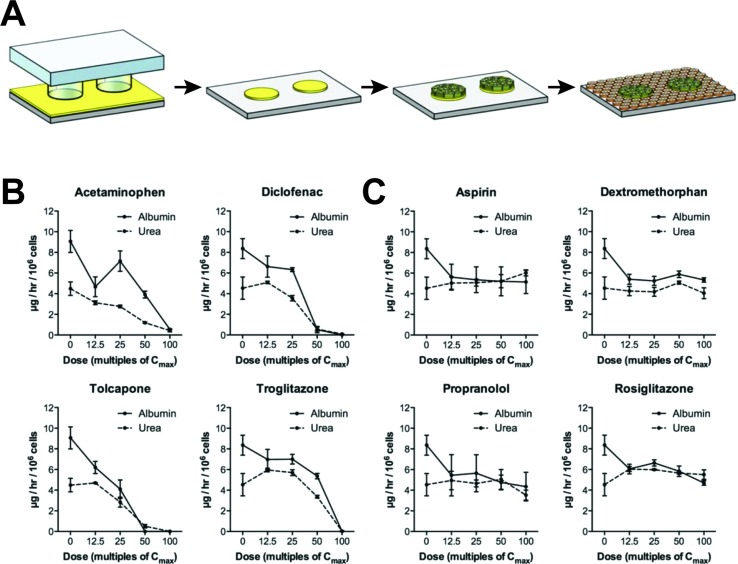
Micropatterned co-cultures (MPCC) support phenotypic maintenance of primary human hepatocytes and hiPS-Heps. (A) MPCCs are established by seeding PHH or hiPS-Heps on micropatterned islands of ECM substrate, followed by seeding of supportive murine fibroblasts. Albumin and urea secretion as proxies for cell health can distinguish four hepatotoxins (B) from four nontoxic compounds (C) after 8 days of exposure in hiPS-Hep MPCC. Figure modified with permission from (Berger et al., 2015).